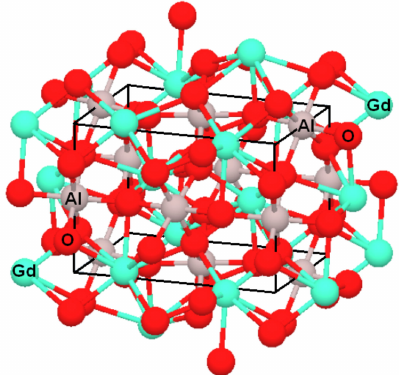
Figure 3. Spatial structure and unit cell of GdAlO 3